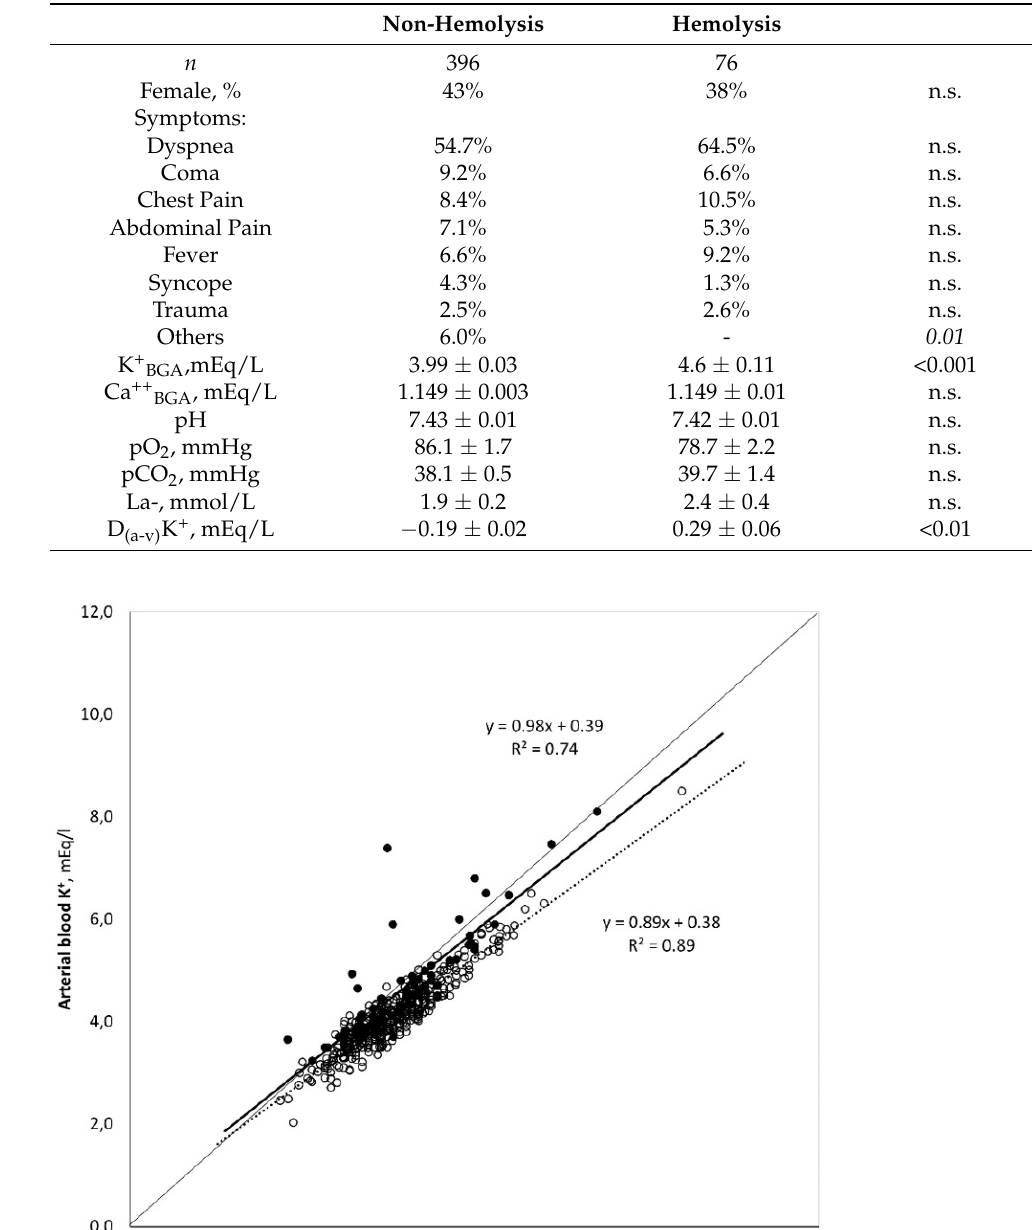
Table 3. Classification of the analyzed sample and the results, shown as the mean ± SE. The significance of the difference has been assessed by a t-test. Ca ++ , ionized calcium (mEq/L); K + BGA, arterial potassium (mEq/L); La- (lactid acid (mmol/L)); pCO 2 , partial pressure of carbon dioxide (mmHg); pO 2 , oxygen partial pressure (mmHg); D(a-v)K, difference between arterial and venous potassium value.